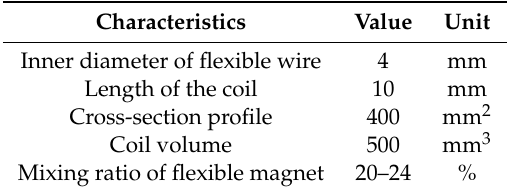
Table 3. Optimal design characteristics of a single ESA.